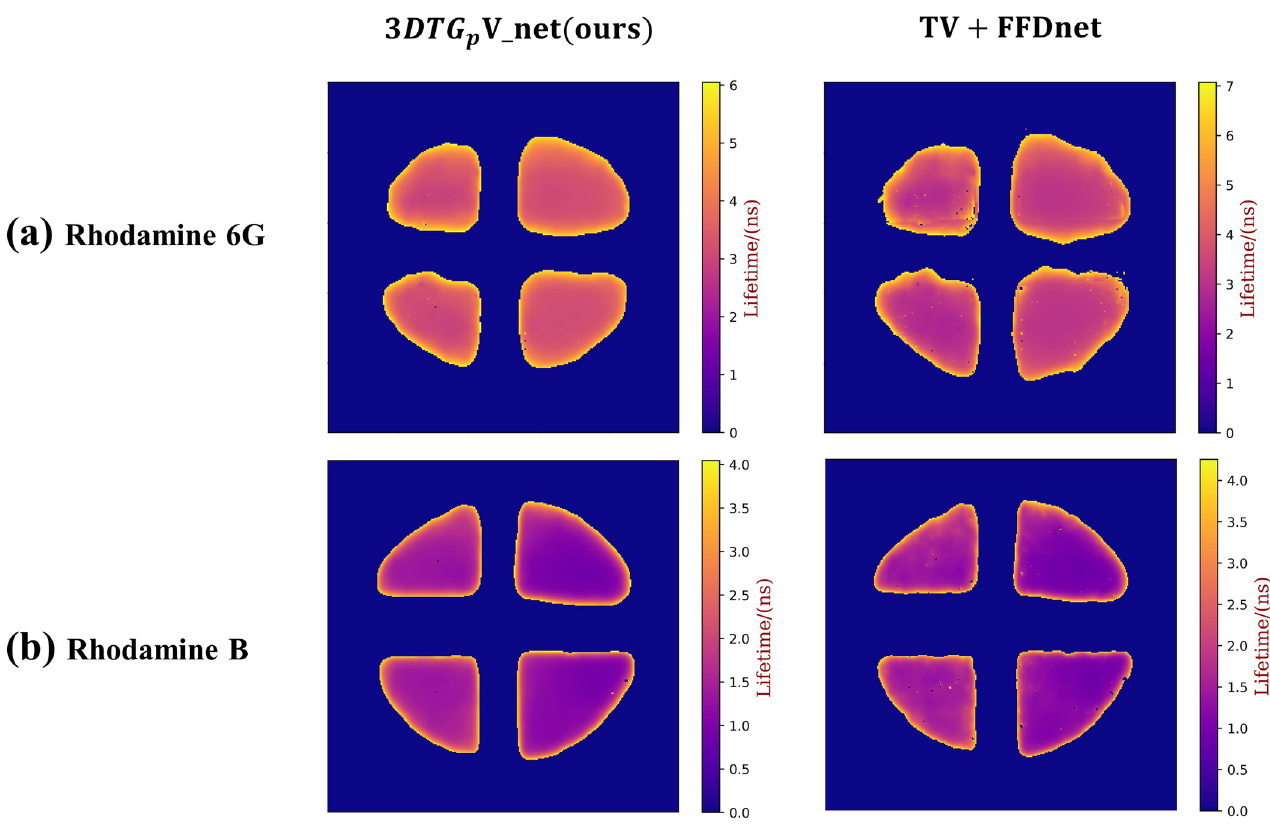
Fig 8. Comparison with 2D lifetime